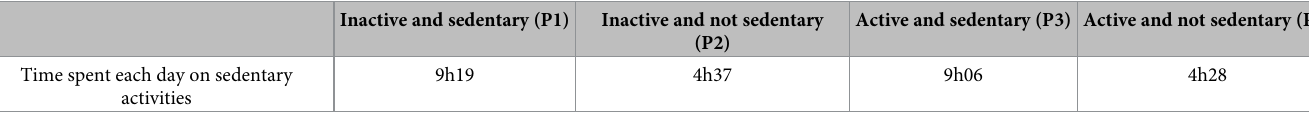
Table 11. Daily time spent on sedentary activities by PA & SB